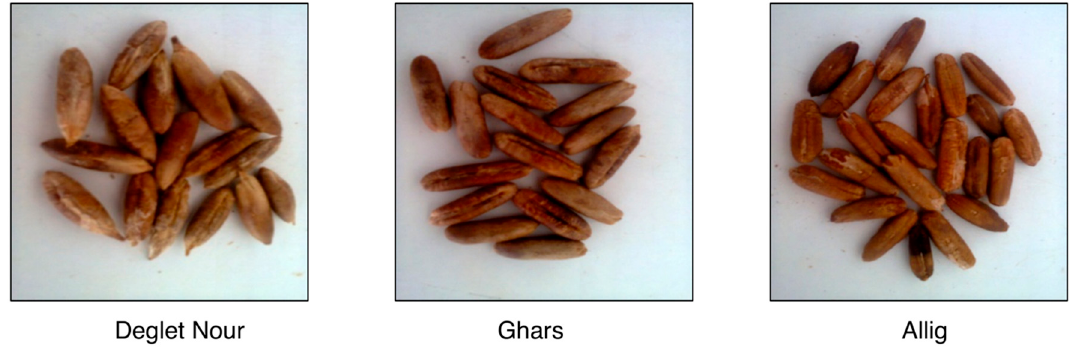
Figure 1. Photos of the different date seed varieties.